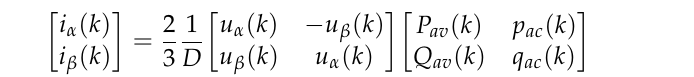
Figure 12. Waveforms of distortion power components 𝐷 𝑎𝑣 (𝑘) during transient states calculated by different methods (MAF-, DFIR, and DIIR filters) ( a ), and the corresponding deformation component of the current using the MAF method ( b ).